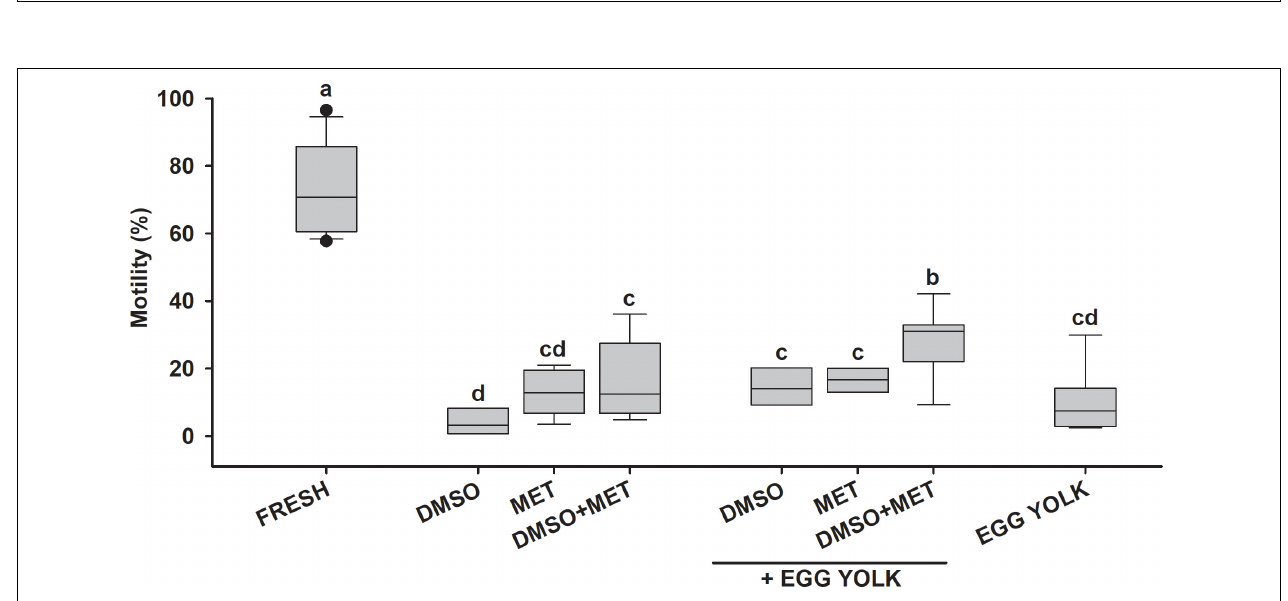
FIGURE 5 | Cryopreservation results in rays. Motility and viability results for sperm cryopreservation protocols in skates ( n = 11). Sperm obtained from Raja asterias , Raja clavata , Raja montagui, and Raja radula were diluted with artificial elasmobranch seminal plasma extender (EE) and frozen using different cryoprotectant combinations: dimethyl sulfoxide (DMSO), methanol (MET) or DMSO + MET. FRESH represents the motility and viability values in fresh sperm samples prior to freezing. Different letters mean significant differences between viability or motility values from each protocol.